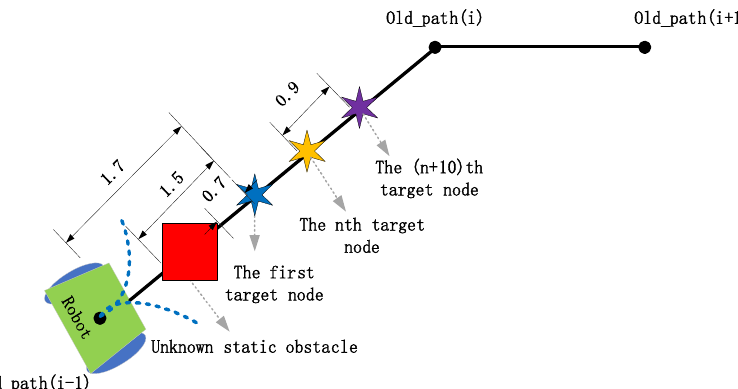
Figure 7. Schematic diagram of the improved local target point tracking method.